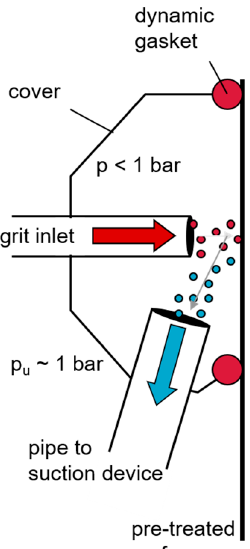
Figure 6. Schematic design of a low-pressure blasting device. Adapted from [138].